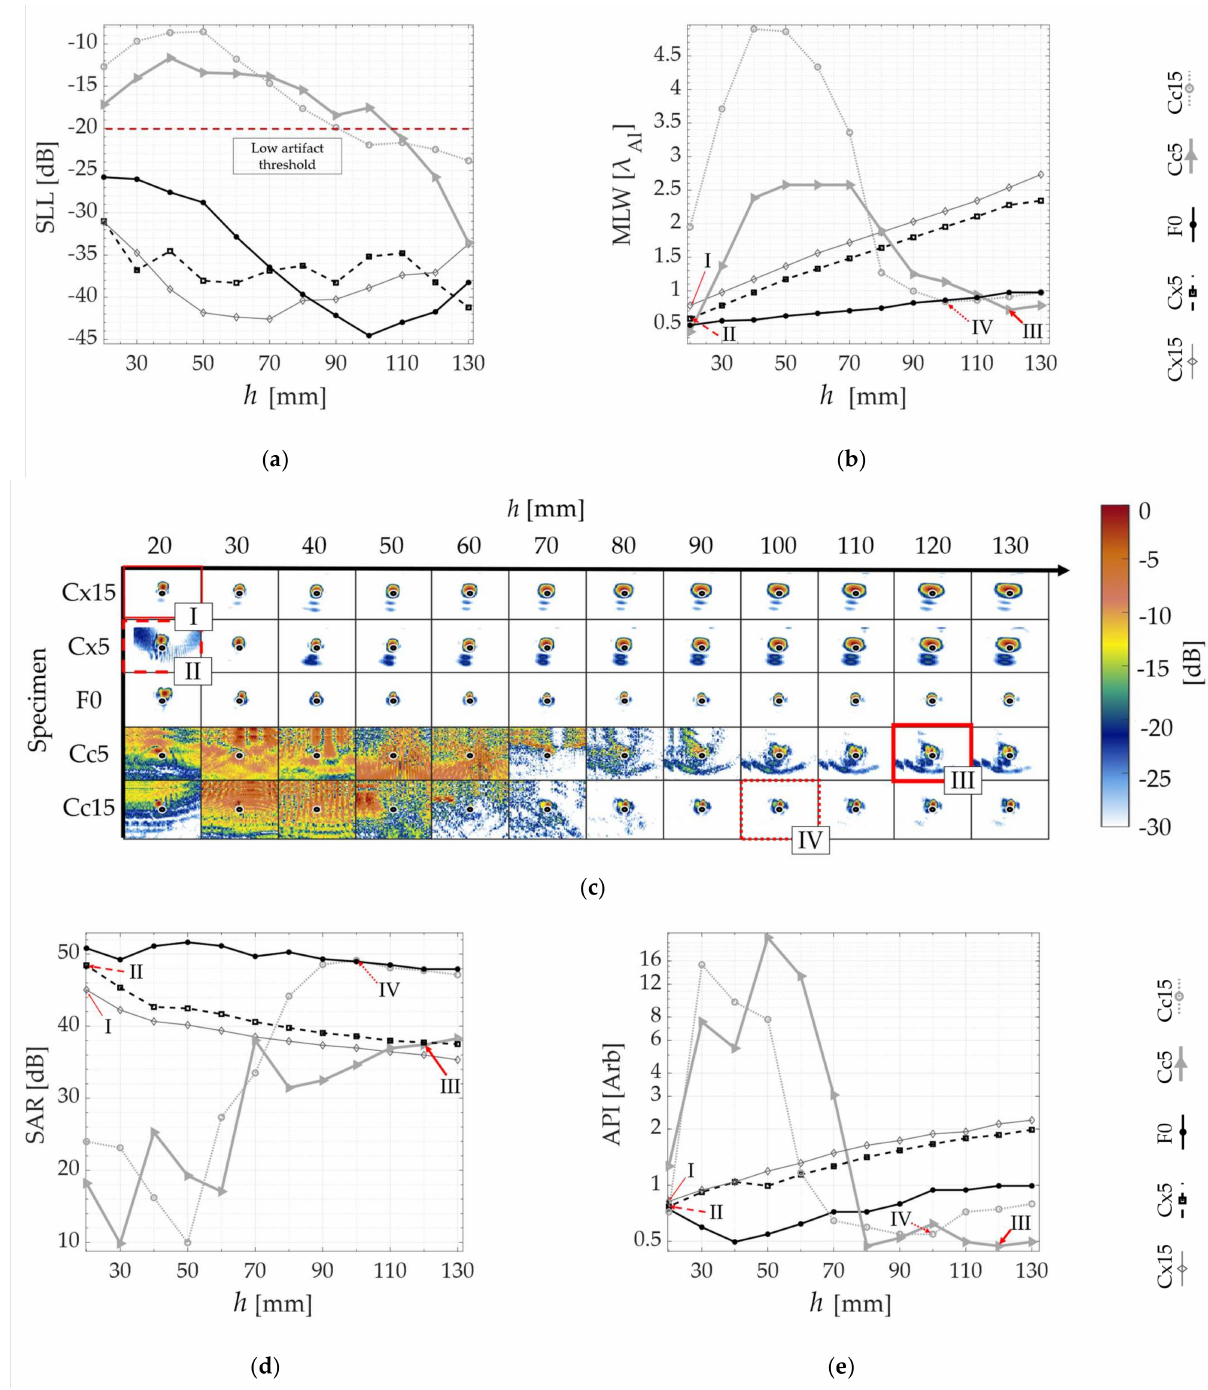
Figure 7. PSOM and experimental results from the SDH at 10 mm depth inside each specimen: ( a ) SLL obtained from PSF ( x ) at each standoff h ; ( b ) MLW vs. h ; ( c ) TFM images at different probe standoffs h in each of the five specimens; ( d ) SAR vs. standoff; ( e ) API vs. standoff. The numbers I, II, III and IV indicate the optimal probe standoffs selected by the